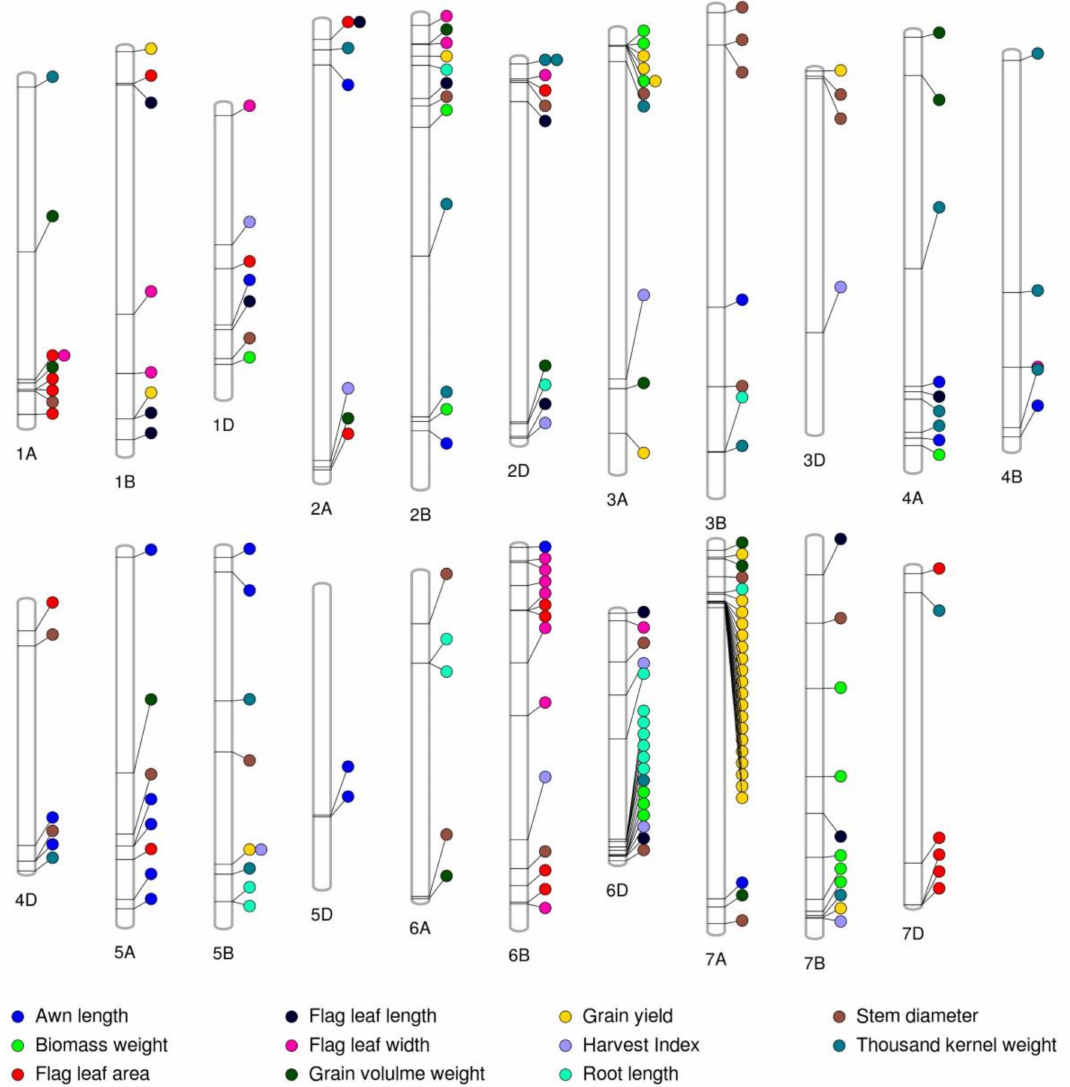
Figure 2. Significant markers trait associations identified on each chromosome for grain yield and yield-related traits obtained from the genome-wide association study of 123 synthetic hexaploid wheats grown in 2016 and 2017 in Konya,